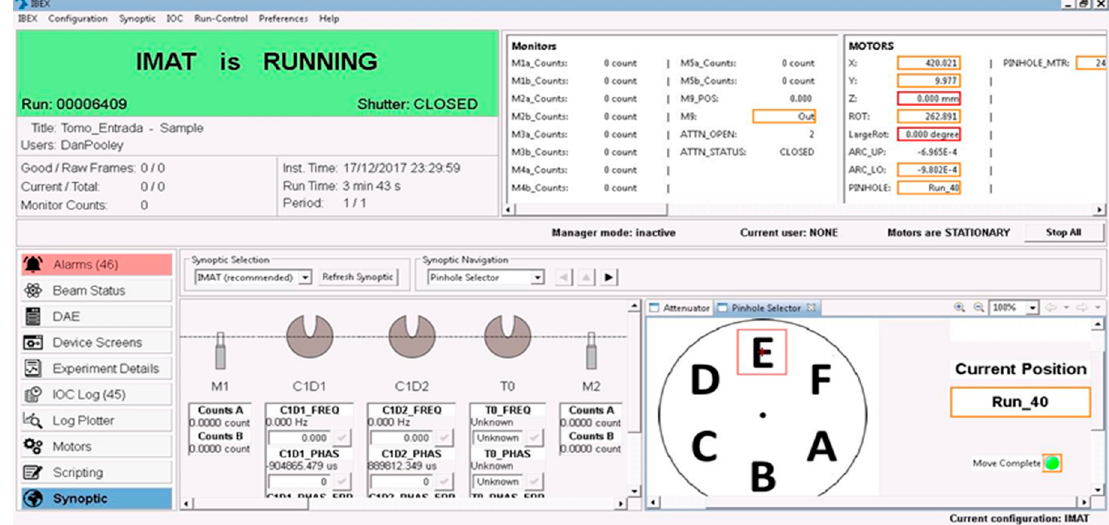
Figure 7. IBEX Graphical User Interface: IMAT instrument and camera control.